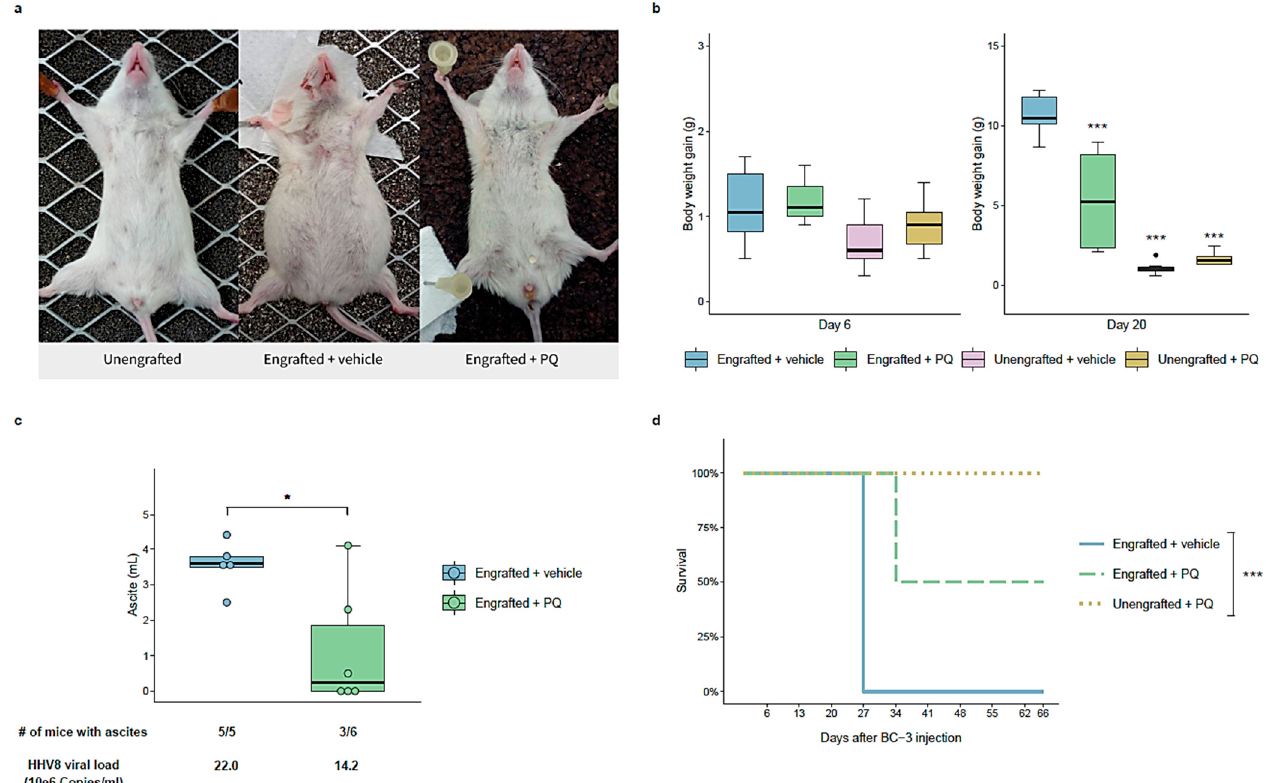
Figure 7 . PQ reduced PEL progression in a NOD/SCID mice PEL model. In total, 10 7 BC-3 cells (BC-3-engrafted) or PBS (BC-3-ungrafted) were injected intraperitoneally (i.p) in NOD/SCID mice ( n = 6 per group). Beginning 24 h later, PQ (25 mg/kg) or PBS (vehicle) was administrated via i.p 3 days per week. The mice were euthanized when moribund or showing signs of discomfort and/or when weight reached 150% of their initial weight. ( a , c ) Representative photographs of animals and ascites fluid volumes were collected immediately postmortem. ( b ) The body weight of each mouse was recorded every week. Median body weight gain of mice is represented for each indicated group with a box plot 6 days and 20 days after BC-3 cell injection. ***, p < 0.001 vs. engrafted + vehicle group (two-way ANOVA analysis and Tukey’s multiple comparisons test). ( c ) Distribution of tumor ascites volume is represented with a box plot within engrafted + PQ and engrafted + vehicle groups. Ascites incidence and HHV-8 viral load (HHV-8 copy number/mL) are also shown for each group. One of the mice of the engrafted vehicle-treated group was removed from this analysis because it showed severe alterations in its health and had to be sacrificed despite presenting no production of ascites. *, p < 0.05 vs. engrafted + vehicle group (Welch’s t -test). ( d ) Mice survival is represented with